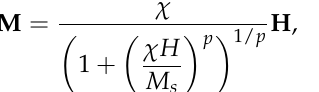
˜ H = | ˜ H | . It can be seen that at p = 2 and χ = 2.6 (red curve) there is good ˜ H = H / M s and agreement with the magnetization curve obtained numerically in the initial section and when reaching